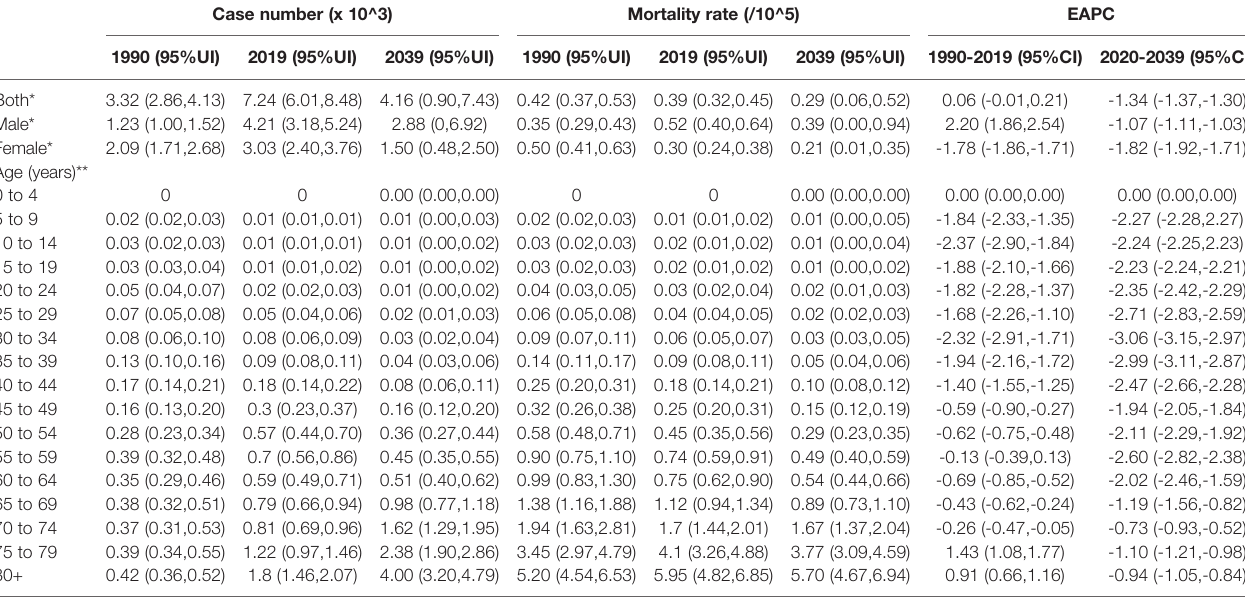
TABLE 2 | The number and mortality rate of thyroid cancer in China by sex and age, during 1990-2019, and projected until 2039.